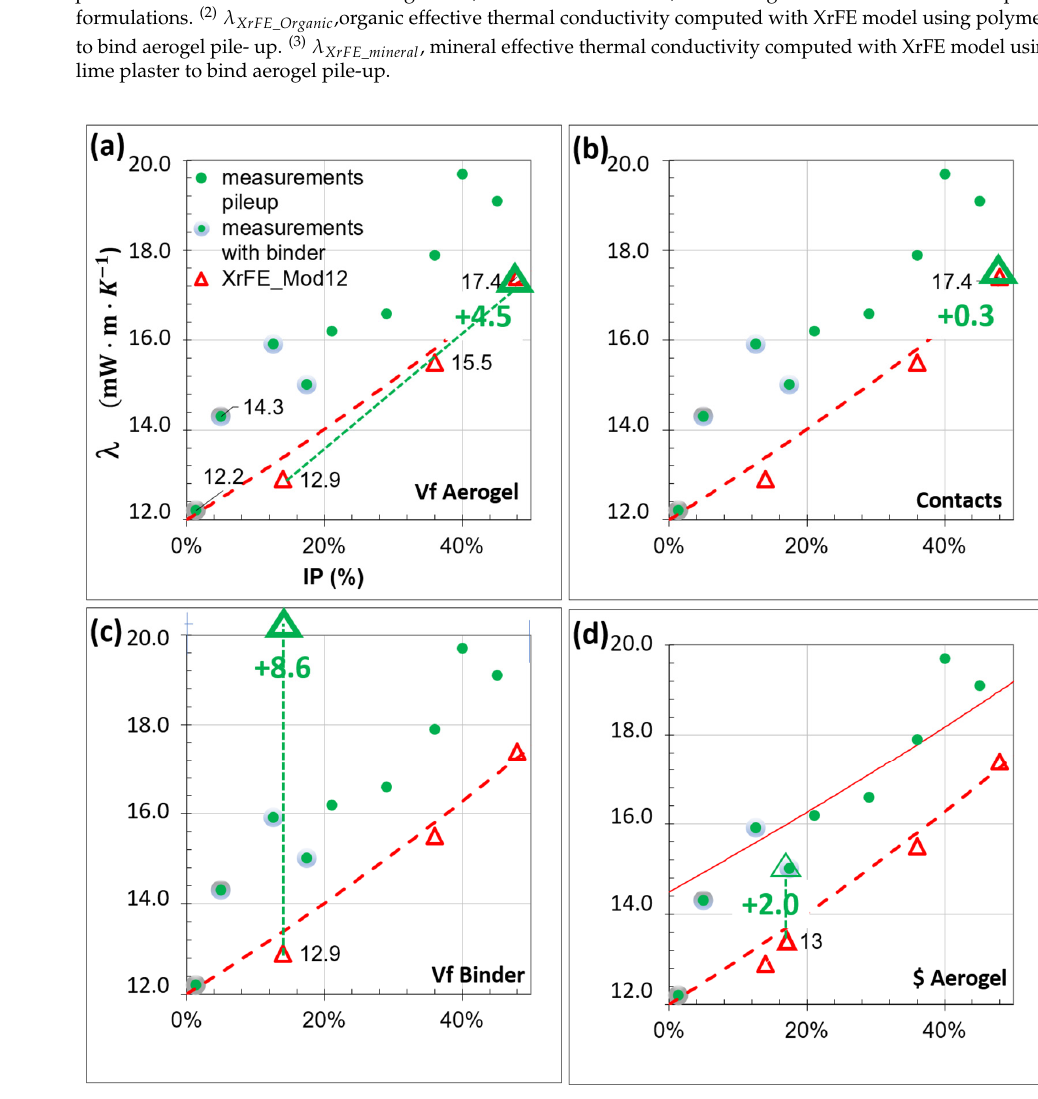
Figure 6. Parametric study on an aerogel composite with the XrFE model. ( a ) 𝑉𝑓 of aerogel, (in- creasing compacity causes a sharp decrease in conductivity); ( b ) the thermal conductivity of the contacts,(including contacts in mesh, is neutral); ( c ) oganic binder, (filling pores with binder causes a huge increase in conductivity); ( d ) aerogel price and efficiency, (when using lower-priced, lower thermal intrinsic conductivity aerogel, XrFE and experimental conductivity are equal). Table 3. Pile-up compacity parameter study, inputs and XrFE simulated conductivities.